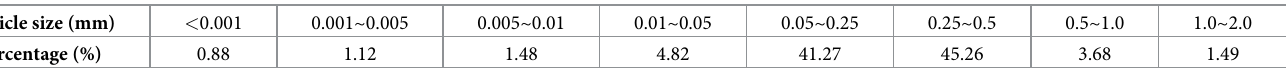
Table 1. The distribution of particle sizes. Particle size (mm) < 0.001